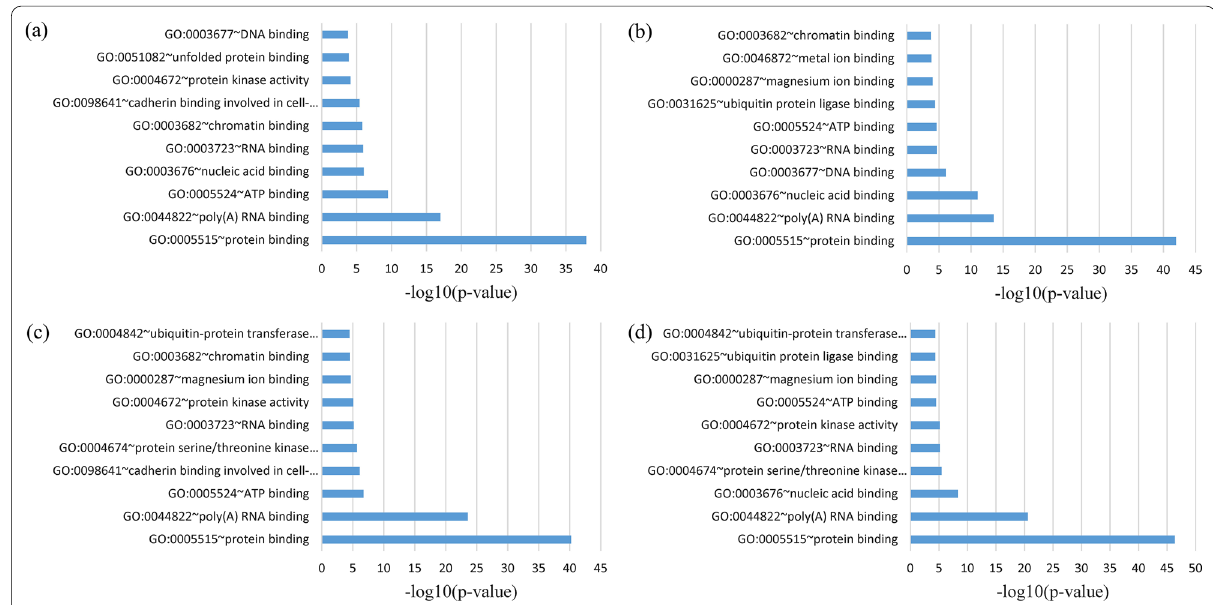
Fig. 2 GO cellular component enrichment analysis of overlapping DEGs: a mild COVID-19 versus CHB, b mild COVID-19 versus HCC, c severe COVID-19 versus CHB, d severe COVID-19 versus HCC datasets